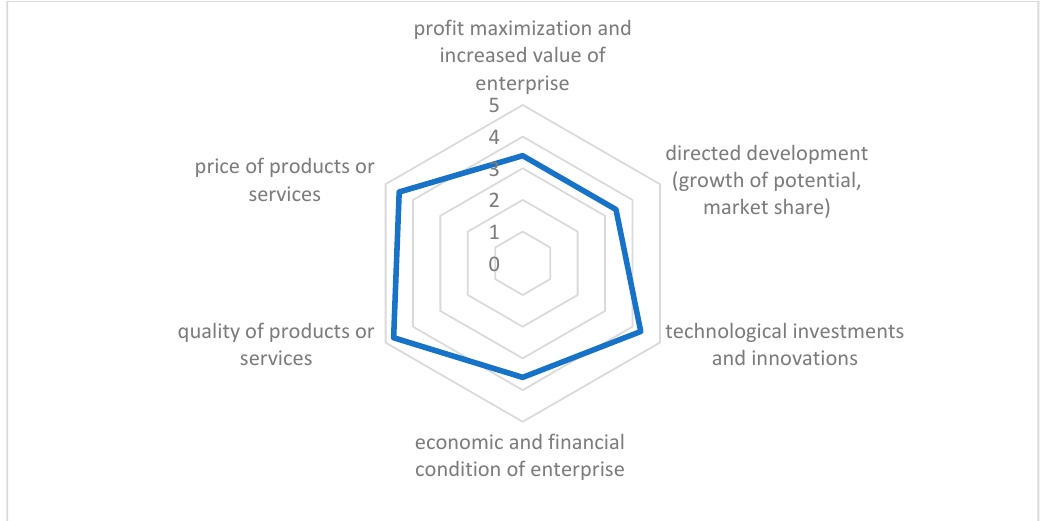
Figure 2. Vital factors that stimulate development and increased competitiveness of design and construction enterprises of PV farms—own research.